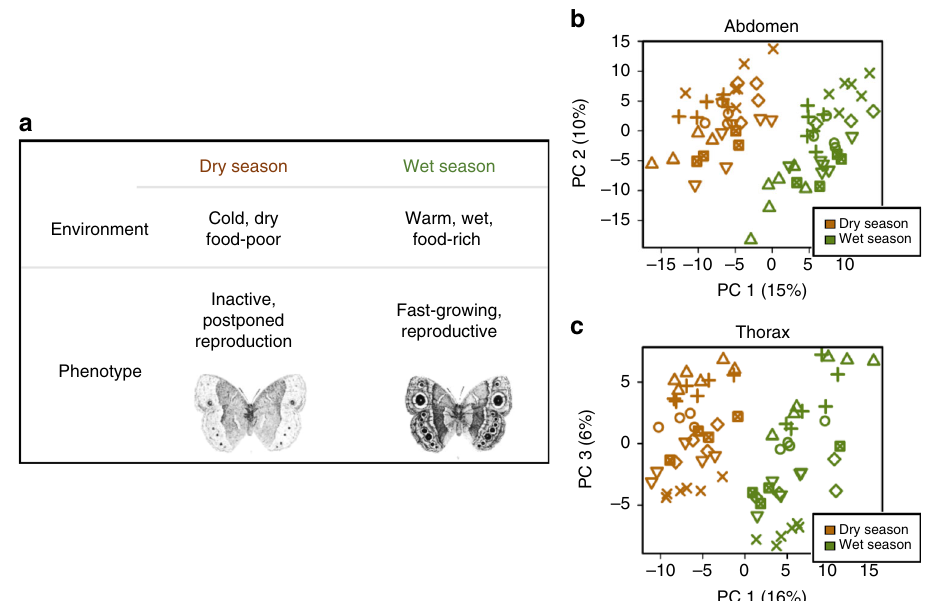
Fig. 1 Pervasive seasonal plasticity and intra-population genetic variation across the transcriptome. a Bicyclus anynana butter fl ies of the dry (brown) and wet (green) season differ in a suite of behavioural, life history, and morphological traits, depending on the seasonal environment in which they developed. b , c Principal components analysis (PCA) of whole-transcriptome expression pro fi les for abdomen ( b ) and thorax ( c ) signi fi cantly separates individuals reared in wet (green) or dry (brown) season conditions along the fi rst Principal Component (accounting for 15 – 16% of variance). For abdomen, the second PC (10% of variance) signi fi cantly separates individuals from different full-sib families (indicated by different symbols), whereas for thorax the third PC (6% of variance) separates families. Families are also signi fi cantly separated by several other PCs, together accounting for 56 and 27% of variance in abdomen and thorax (see Supplementary Figs. 5 and 6 for all PCs and statistical tests). Butter fl y drawings © Clara variance, signi fi cantly separating individuals from wet and dry − 6 season environments (two-way ANOVA F 1,55 > 38, FDR < 10 ; Fig. 1; Supplementary Figs. 5, 6). Hierarchical clustering of gene